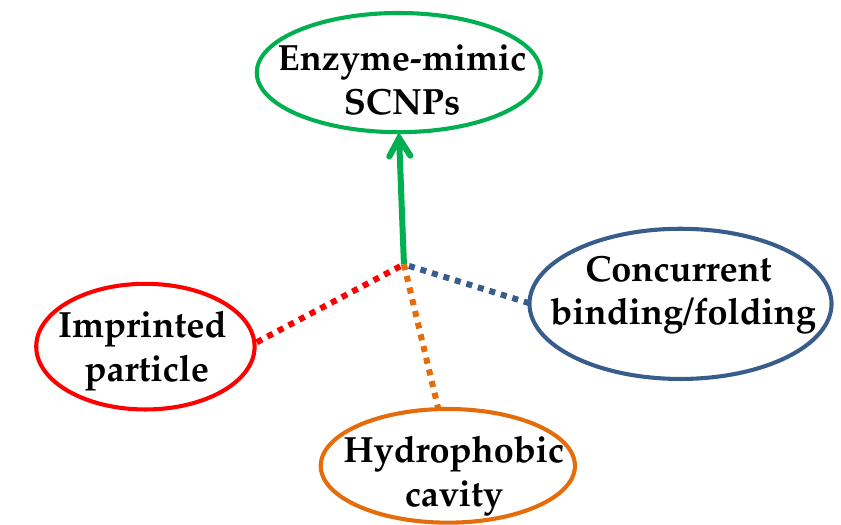
Figure 4. Different strategies to endow SCNPs with enzyme-mimetic activity: imprinted particle route, hydrophobic cavity approach, and concurrent binding/folding technique.